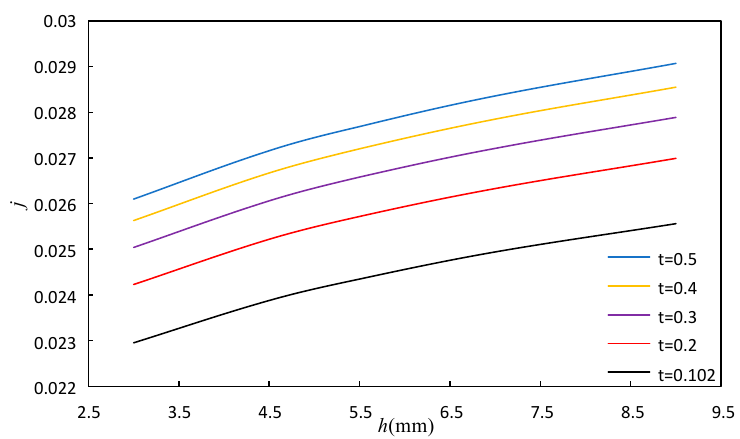
thickness t is 0.102 mm, 0.2 mm, 0.3 mm, 0.4 mm, 0.5 mm. The fin tooth length l and spacing s are maintained at 3.175 mm and 2.62 mm, respectively. Other calculation conditions of the model remain unchanged. Figures 12 and 13 show the effect of h and t on j factor and f factor, respectively. It can be seen from Figures 12 and 13 that when the fin height is fixed, the j factor and the f factor increase with the increase in fin thickness, and the increase in fin thickness t increases the secondary heat transfer area, thus strengthening the heat transfer. The flow space decreases with increasing fin thickness, thereby increasing the flow resistance and increasing the f factor.